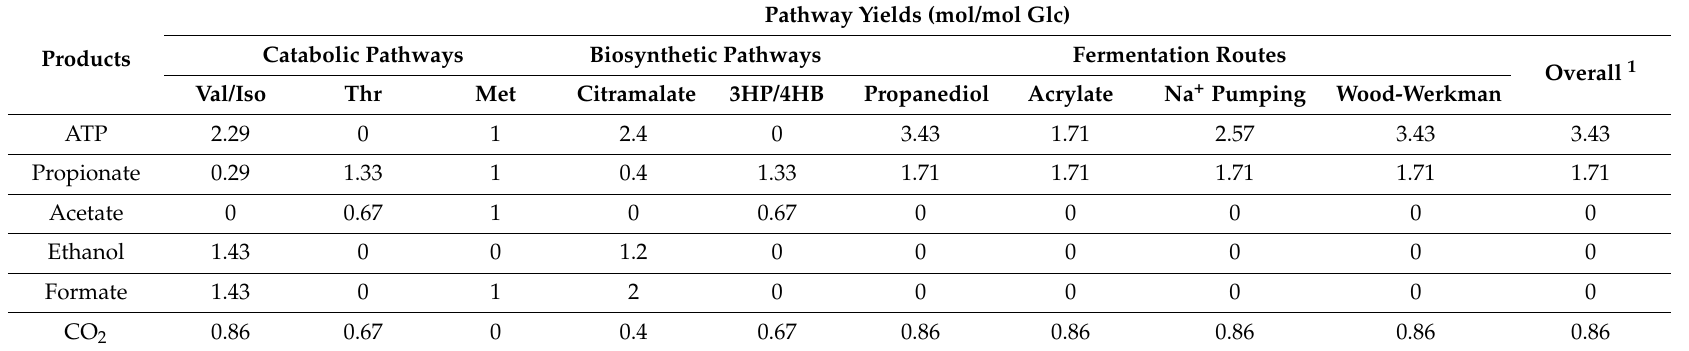
Table 5. Maximum propionate yield analysis of all metabolic pathways leading to propionate production.